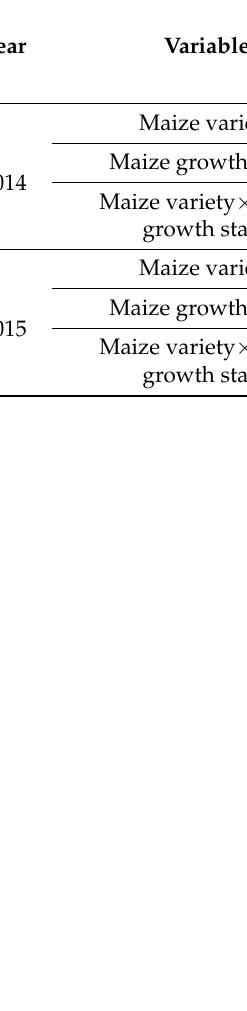
Figure 3. Redundancy analysis (RDA) for the relationship between environmental variables and the collembolan community composition. Table 5. The effects of environmental variables on collembolan community by RDA (Monte Carlo test). The values highlighted in bold are statistically significant (* p < 0.05; ** p < 0.01).